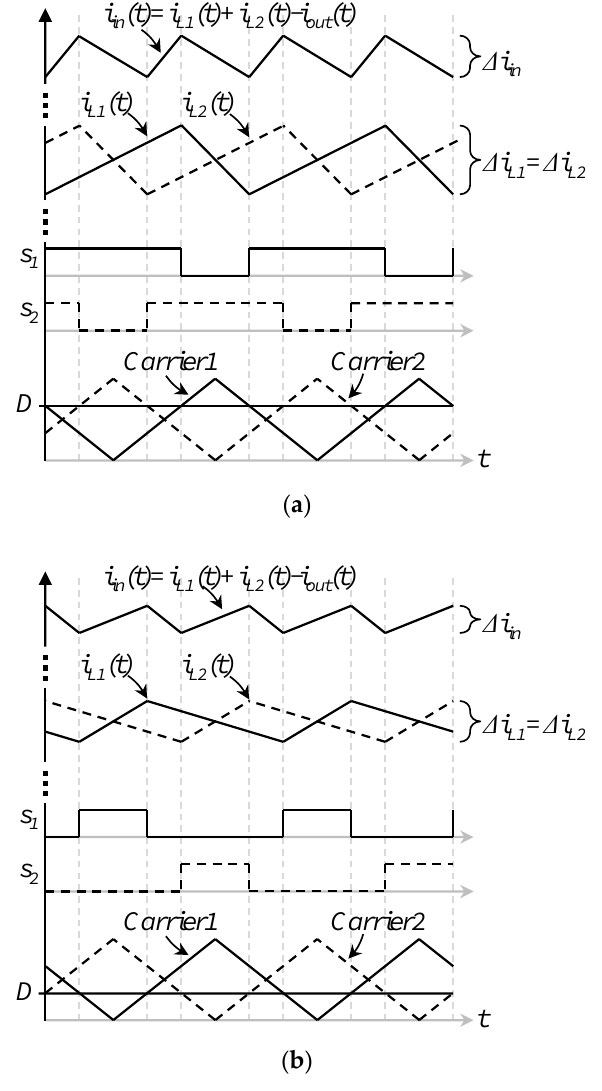
Figure 3. Relevant waveforms in the DDBC ( a ) with a duty ratio of 70%, ( b ) with a duty ratio of 30%.